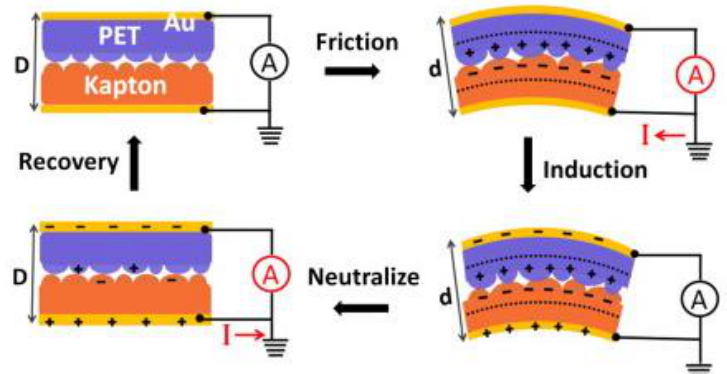
Figure 2. Schematic diagram of triboelectric nanogenerators. (Reproduced with permission [27]. Copyright 2012,